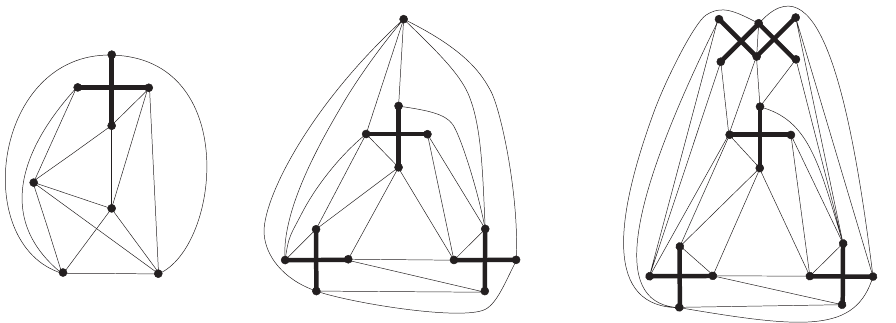
Fig. 1: Realizing drawings of K 6 , K 7 , and K 8 , respectively, where thick edges represent vertex